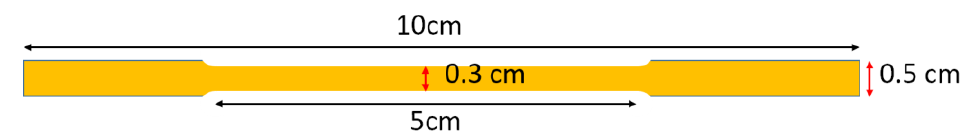
Figure 1. The schematic diagram of the nt-Cu specimen for tensile tests.